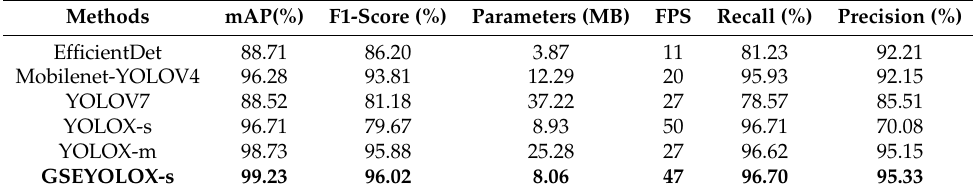
Table 4. Detection results of different target detection models on